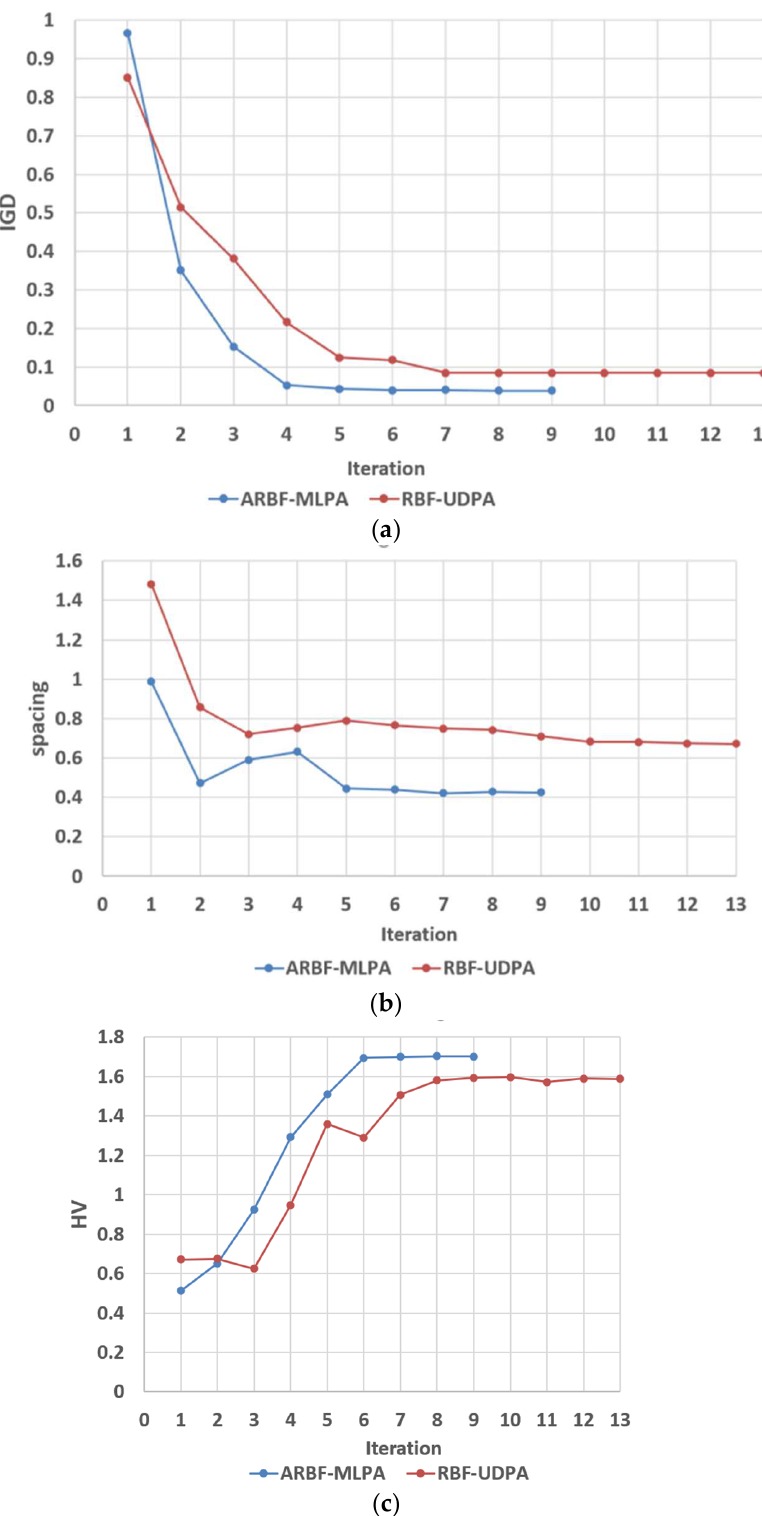
Figure 6. ( a ) IGD under function ZDT3. ( b ) Spacing under function ZDT3. ( c ) HV under function ZDT3.